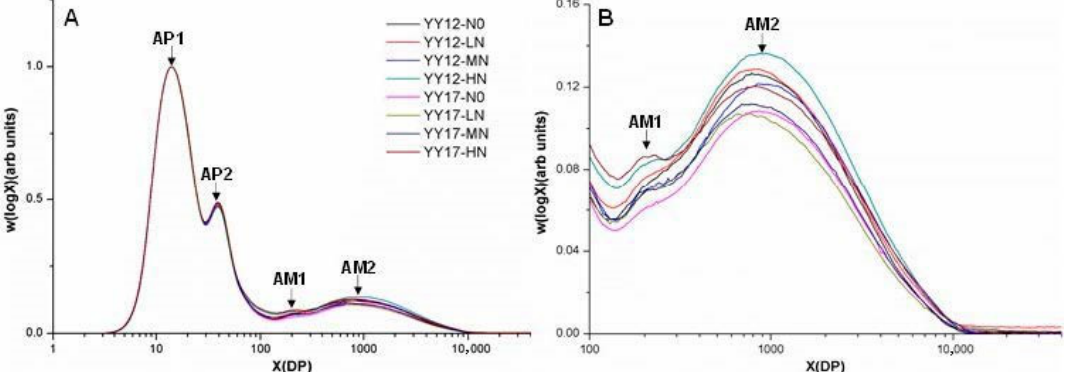
Figure 2. ( A ) Size exclusion chromatography (SEC) weight chain length distribution (CLDs), w(log X), of the debranched starches and ( B ) an enlargement of the amylose region as a function of the degree of polymerization (DP) X. AP1 and AP2 stand for the two amylopectin peaks, while AM1 and AM2 stand for the two amylose peaks. Table 3. Starch molecular parameters extracted from size exclusion chromatography.